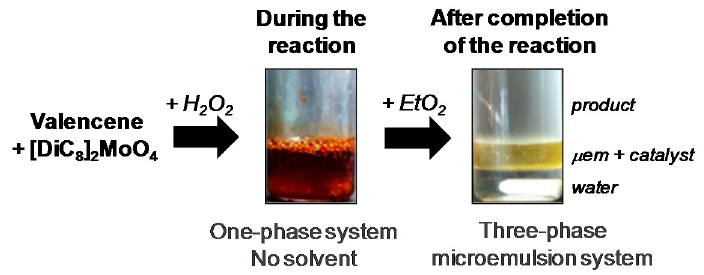
Figure 7. Dark 1 O 2 oxygenation of (+) ‐ valencene into (+) ‐ nootkatone by the system [DiC 8 ] 2 MoO 4 /H 2 O 2 .